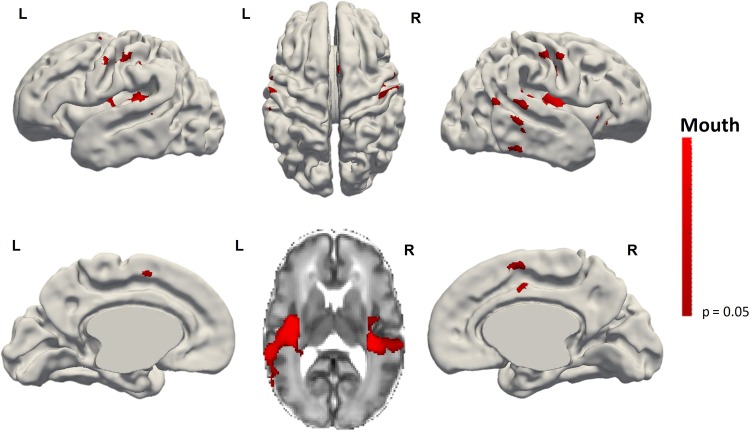
Result of the group analysis of functional responses following mouth stimulation (n = 10). Clusters of activation can be seen within the bilateral sensorimotor cortices. Additional clusters of activation were also seen in the midline Supplementary Motor Area (SMA) (lower row left and right figures) and bilaterally within the insulae (lower row, center image). Images show the results of one-sample nonparametric t-test (P < 0.05 corrected for family wise error) projected onto the gray-white matter boundary of a 34 week PMA template brain.